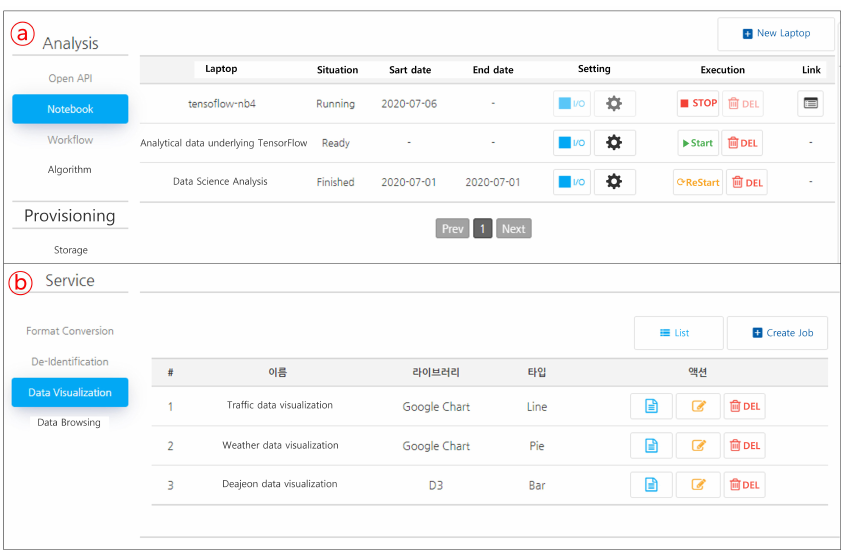
Figure 13. Example screens of the Analytics and Service